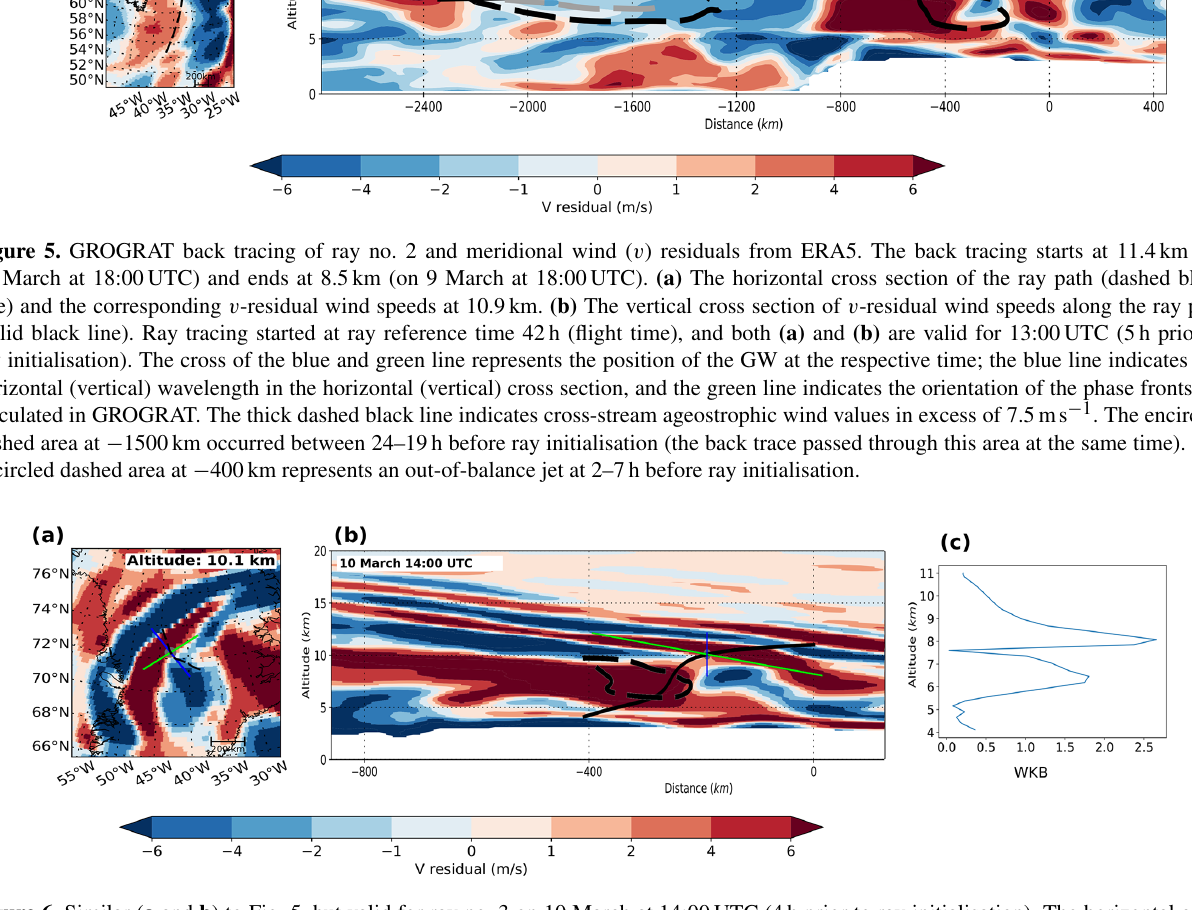
Figure 6. Similar ( a and b ) to Fig. 5, but valid for ray no. 3 on 10 March at 14:00UTC (4h prior to ray initialisation). The horizontal cross section (a) is valid for 10.1km. Panel (b) shows that the ray tracing starts at 11km and ends above the Greenland plateau. The thick dashed black line indicates cross-stream ageostrophic wind values in excess of 7.5ms − 1 . (c) The WKB parameter with height. The WKB parameter can be related to the jet in Fig.